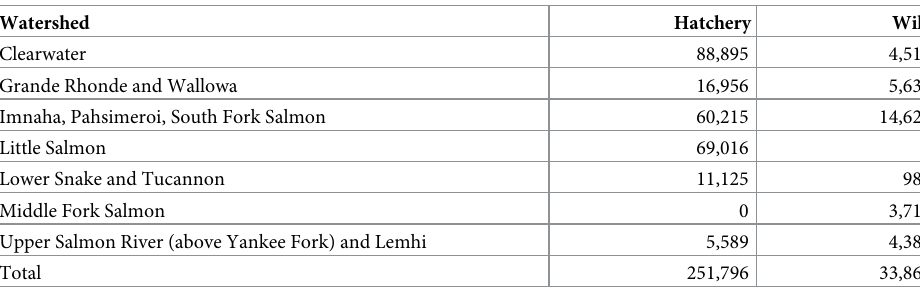
Table 1. Sample sizes for spring/summer Chinook salmon.